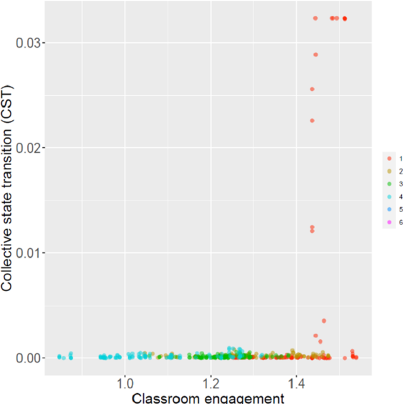
Figure 6. Synchronous movements in the classroom (quantified by collective state transition (CST)) as a function of the average classroom engagement. The colours refer to the different lectures.